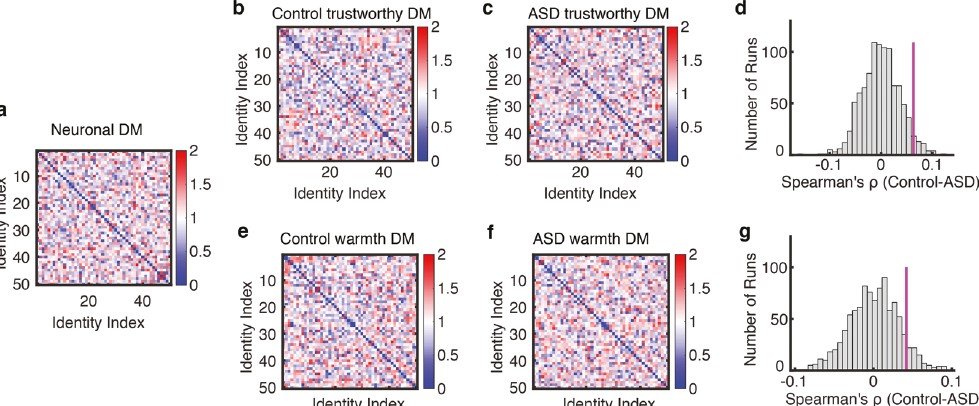
Fig. 4 A stronger neural-rating correspondence in controls than participants with ASD. a Neuronal dissimilarity matrix (DM) constructed across face examples. b, c, e, f Social DM constructed across ratings of face examples in a single trait. b, e DM of trustworthiness and warmth from neural typical participants. c, f DM from participants with ASD. d, g Observed vs. permuted difference in DM correspondence between participant groups. The magenta line indicates the observed difference in DM correspondence between participant groups. The null distribution of difference in DM correspondence (shown in gray histogram) was calculated by permutation tests of shuf fl ing the participant labels (1000